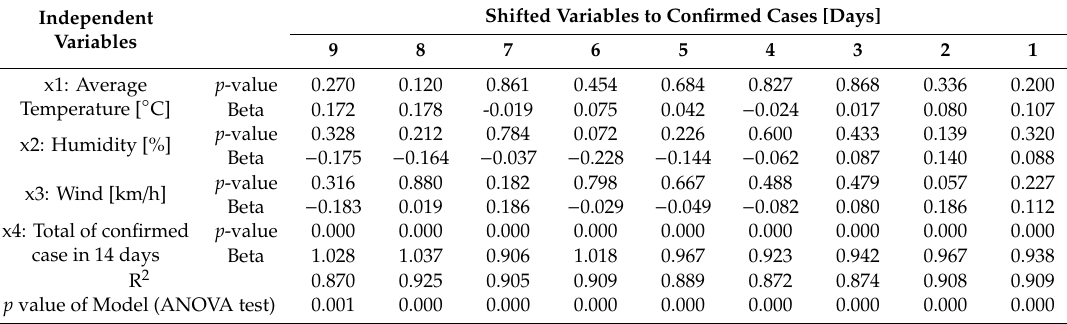
Table 5. The result of multivariate linear regression, Emilia-Romagna (Bologna).